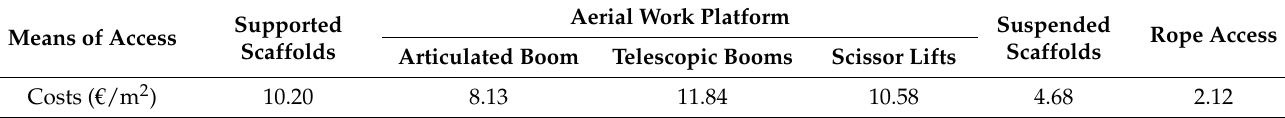
Table 1. Unit cost, at year 0, for the different means of